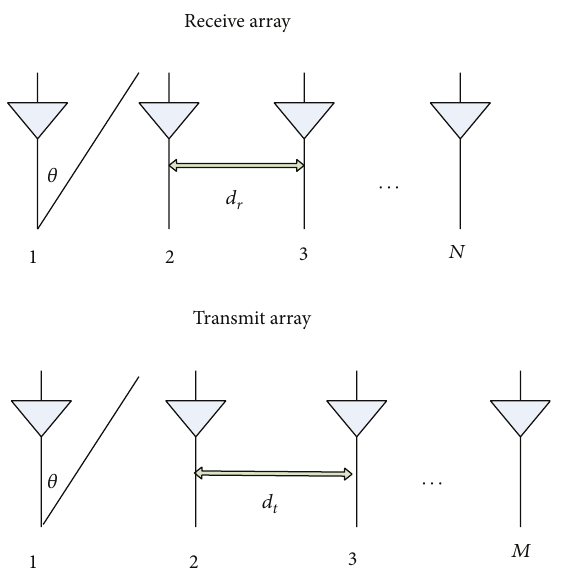
Figure 1: Transmit and receive